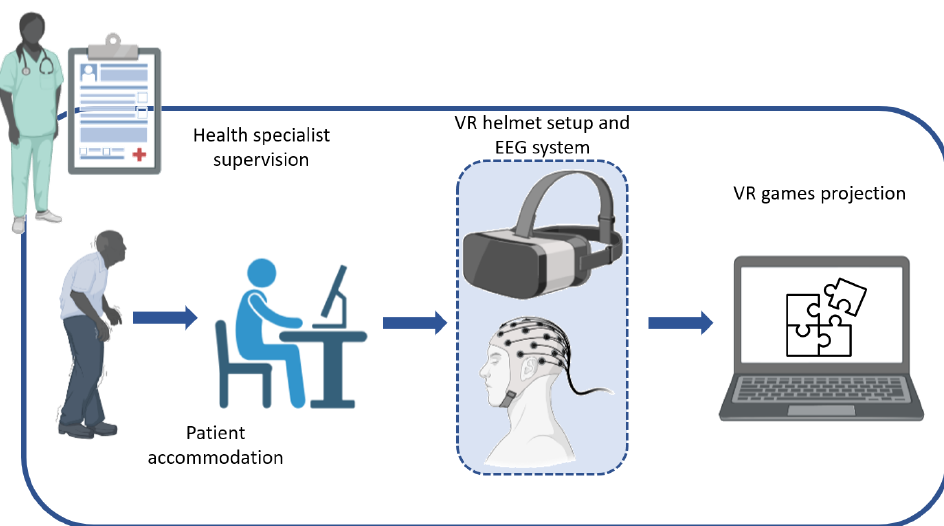
Figure 2. Assembly was carried out during the intervention with the VR system performed in the rehabilitation center in